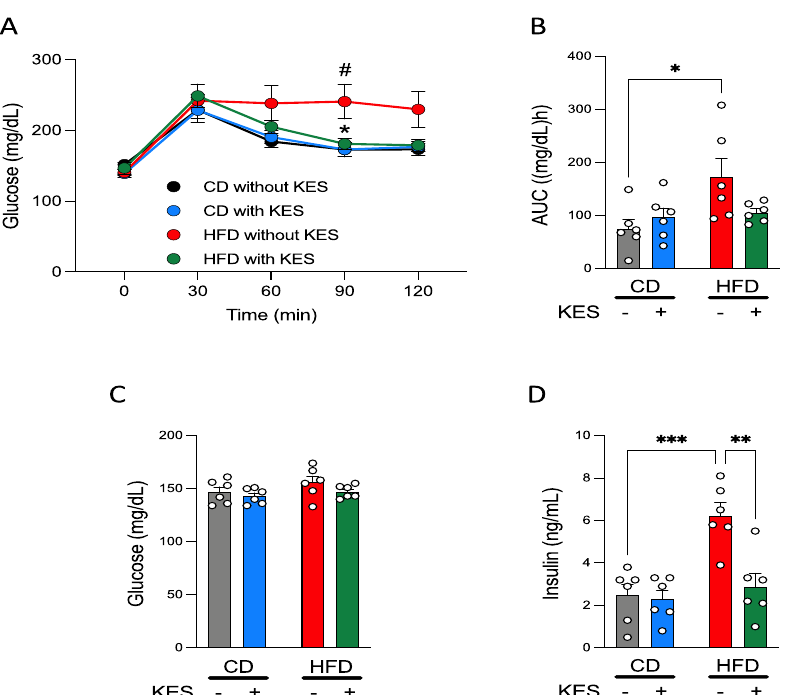
Figure 1. 1-Kestose suppresses the development of insulin resistance. ( A ): Oral glucose tolerance tests (OGTTs) were conducted on rats fed CD or HFD with or without KES. ( B ): An AUC-glucose during OGTTs. ( C ): Fasting plasma glucose concentrations were measured after 18 weeks of the experiment. ( D ): Fasting plasma insulin concentrations were measured after 18 weeks of the experiment. p values were determined using two-way ANOVA with Tukey-Kramer’s test. ( A ): * p < 0.05 HFD with KES vs. HFD without KES. # p < 0.05 HFD without KES vs. CON without KES. ( B , D ): * p < 0.05, ** p < 0.01, and *** p < 0.001. Abbreviations: CD, control diet; HFD, high-fat diet; KES, 1-kestose; AUC, area under the curve.